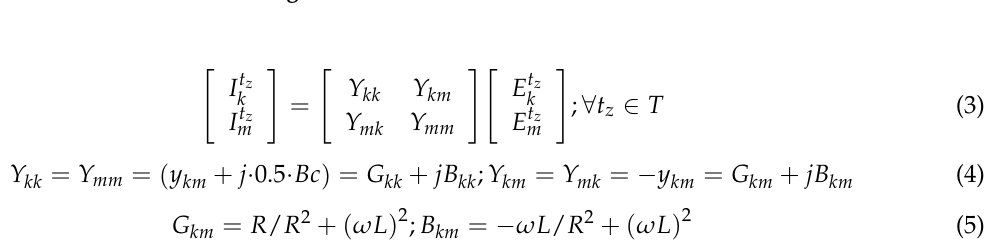
Figure 1. π circuit for the feeders.